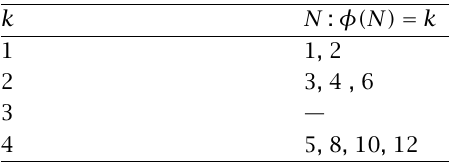
Table 3.1 . Solutions of φ(N) = k with k ≤ 4, (see [7, page